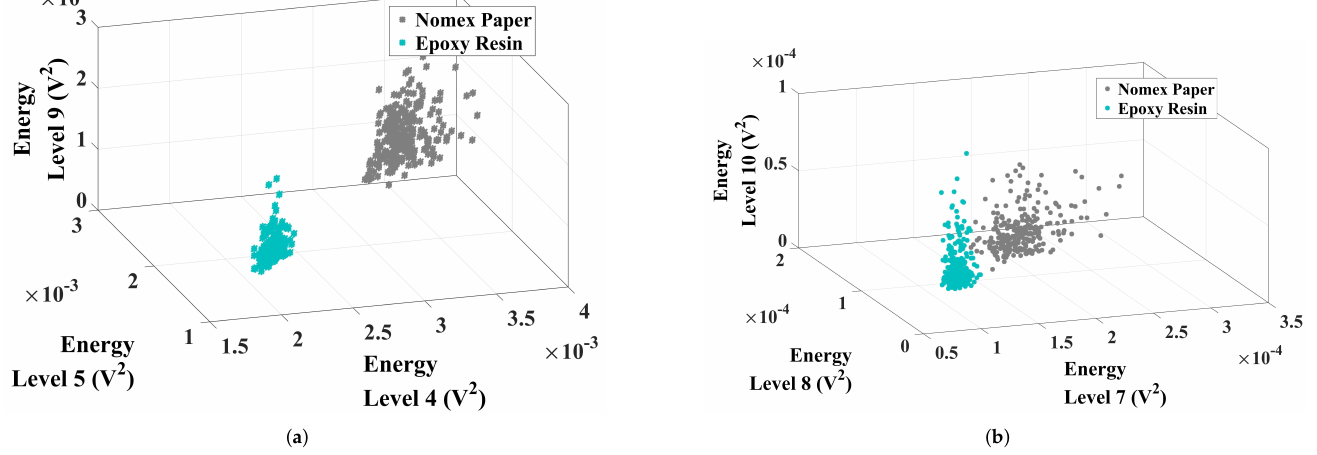
Figure 13. Clusters formed by the best combinations of ( a ) approximation and ( b ) detail